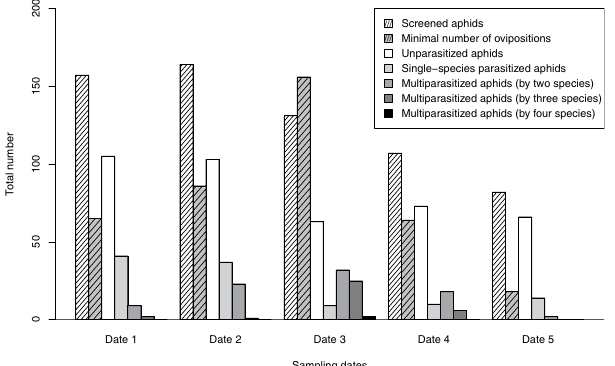
Figure 2. Total number of screened aphids, minimal number of ovipositions, unparasitized aphids and parasitized/multiparasitized aphids per each sampling date using the molecular approach.